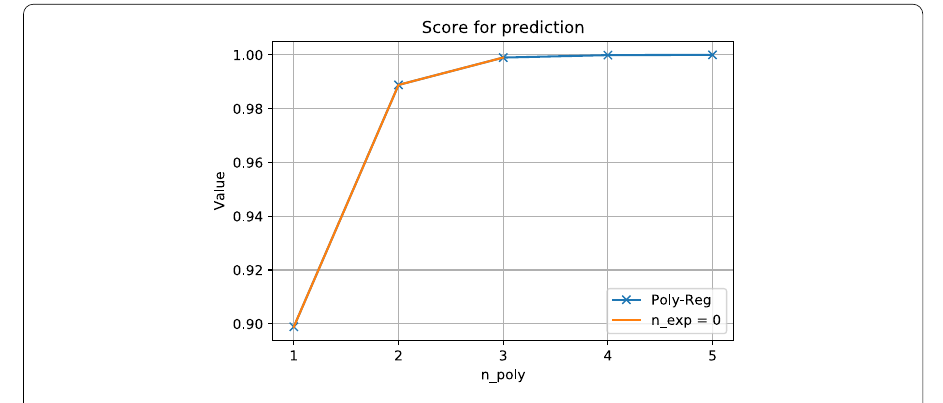
Fig. 11 Identical models. Identical score results for different degrees in (2) and